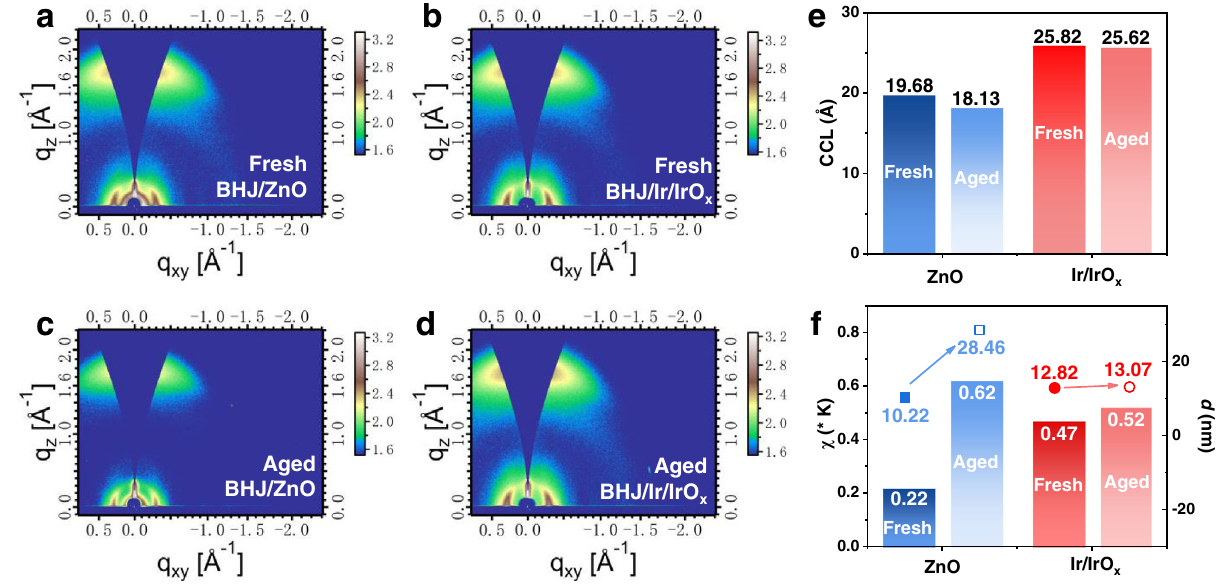
Fig. 6 | Morphology evolution of BHJ fi lms. The two-dimensional (2D) grazing incidence wide-angle X-ray diffraction (GIWAXS) patterns of fresh ( a ) and aged ( b ) PM6:Y6 fi lmonZnO;fresh( c )andaged( d )PM6:Y6 fi lmonIr/IrO x .Thecomparison ofcoherencelength(CCL)( e ),Flory-Hugginsparameters( χ ),anddomainsize( d )( f )